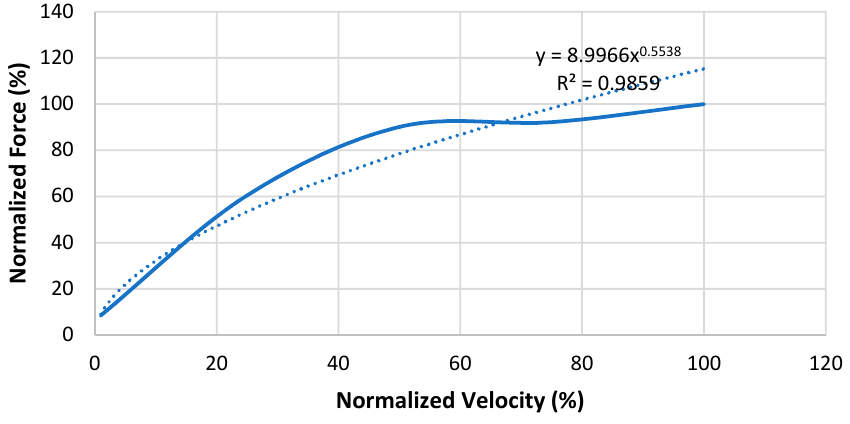
Figure 4. Force vs. velocity.